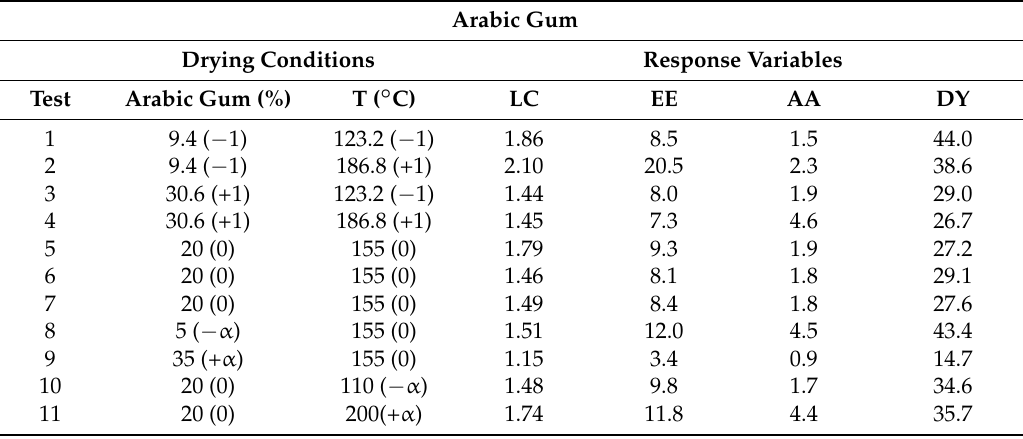
Table 1. Experimental design with coded and decoded values of independent variables and spray drying responses for each wall